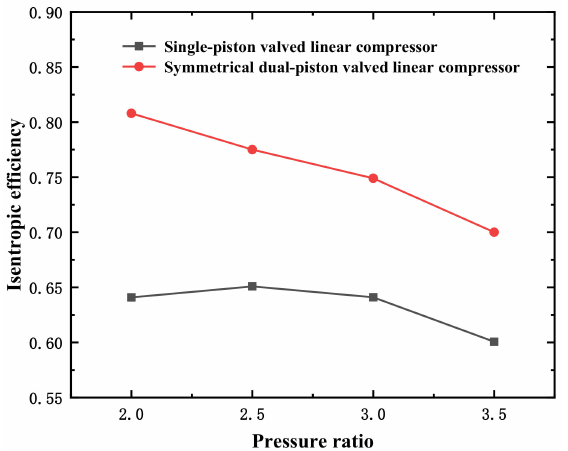
Figure 15. The isentropic efficiencies of the two types of linear compressors at different pressure ratios, obtained from the